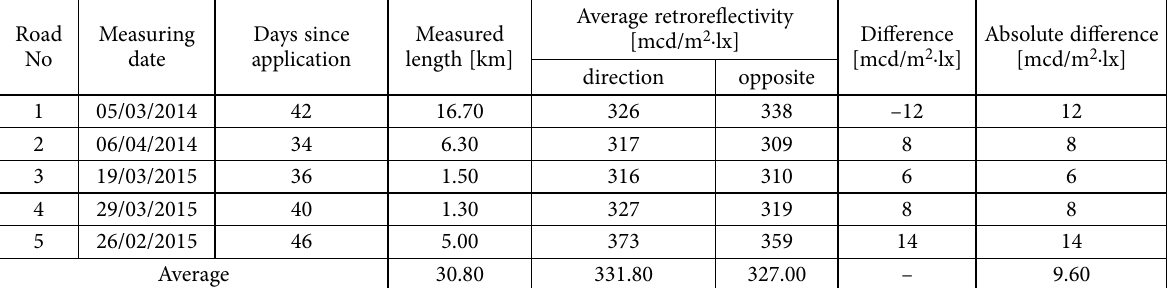
Table 3. Results of retroreflectivity measurement in the direction of application and the opposite direction for renewed thermoplastic